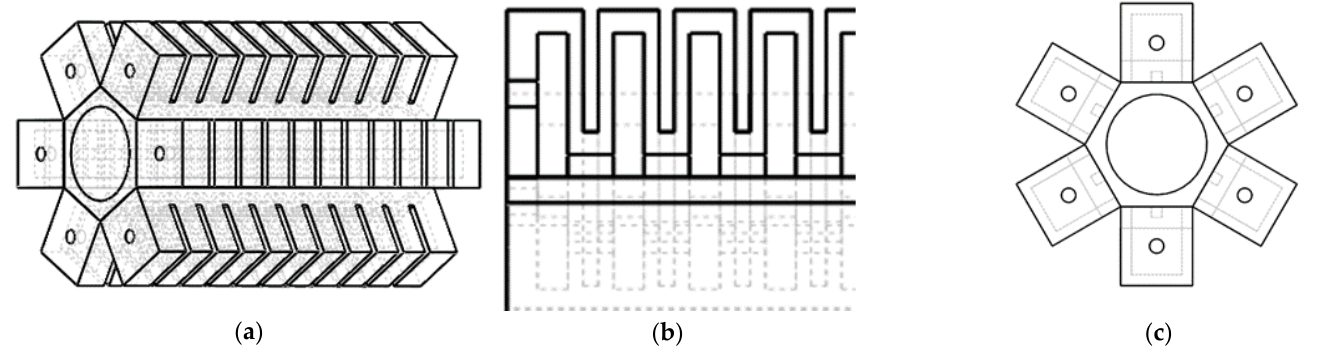
Figure 2. Structure diagram of hexagonal prism soft-bodied bionic actuator. ( a ) Overall structure of actuator. ( b ) Partial view of actuator section. ( c ) Actuator end view.